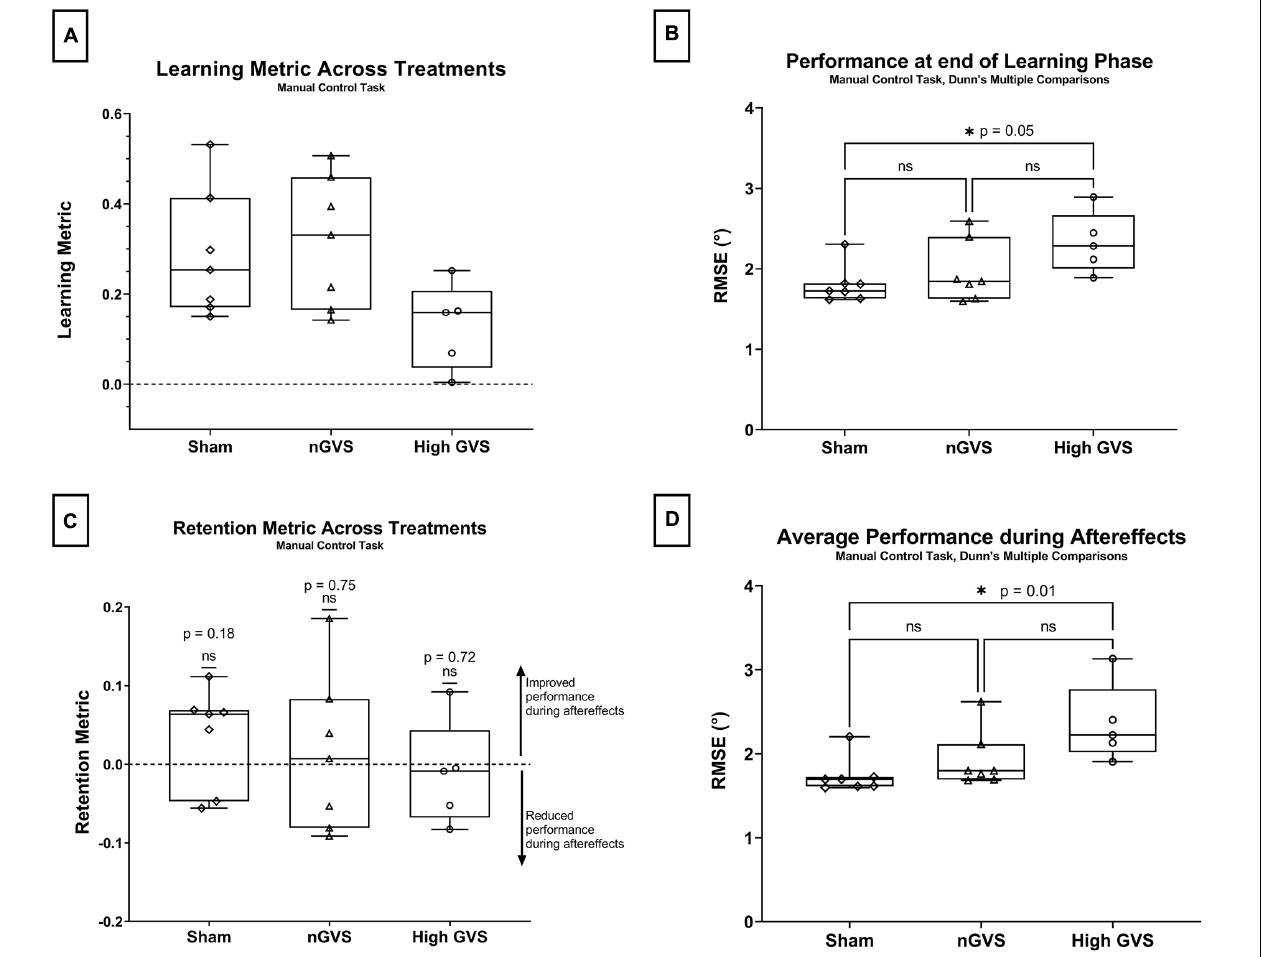
FIGURE 4 | Manual control data analysis. The symbol * denotes significant comparisons at α = 0.05. (A) Comparison of learning metric across treatments. No global significance between treatments. (B) Comparison of nulling performance at the end of the learning phase (L end ) across treatments. (C) Comparison of retention metric across treatments shows no significant change in performance between end of learning phase and average performance during aftereffects for any treatment. (D) Average nulling performance during aftereffects (AE avg ) across treatment